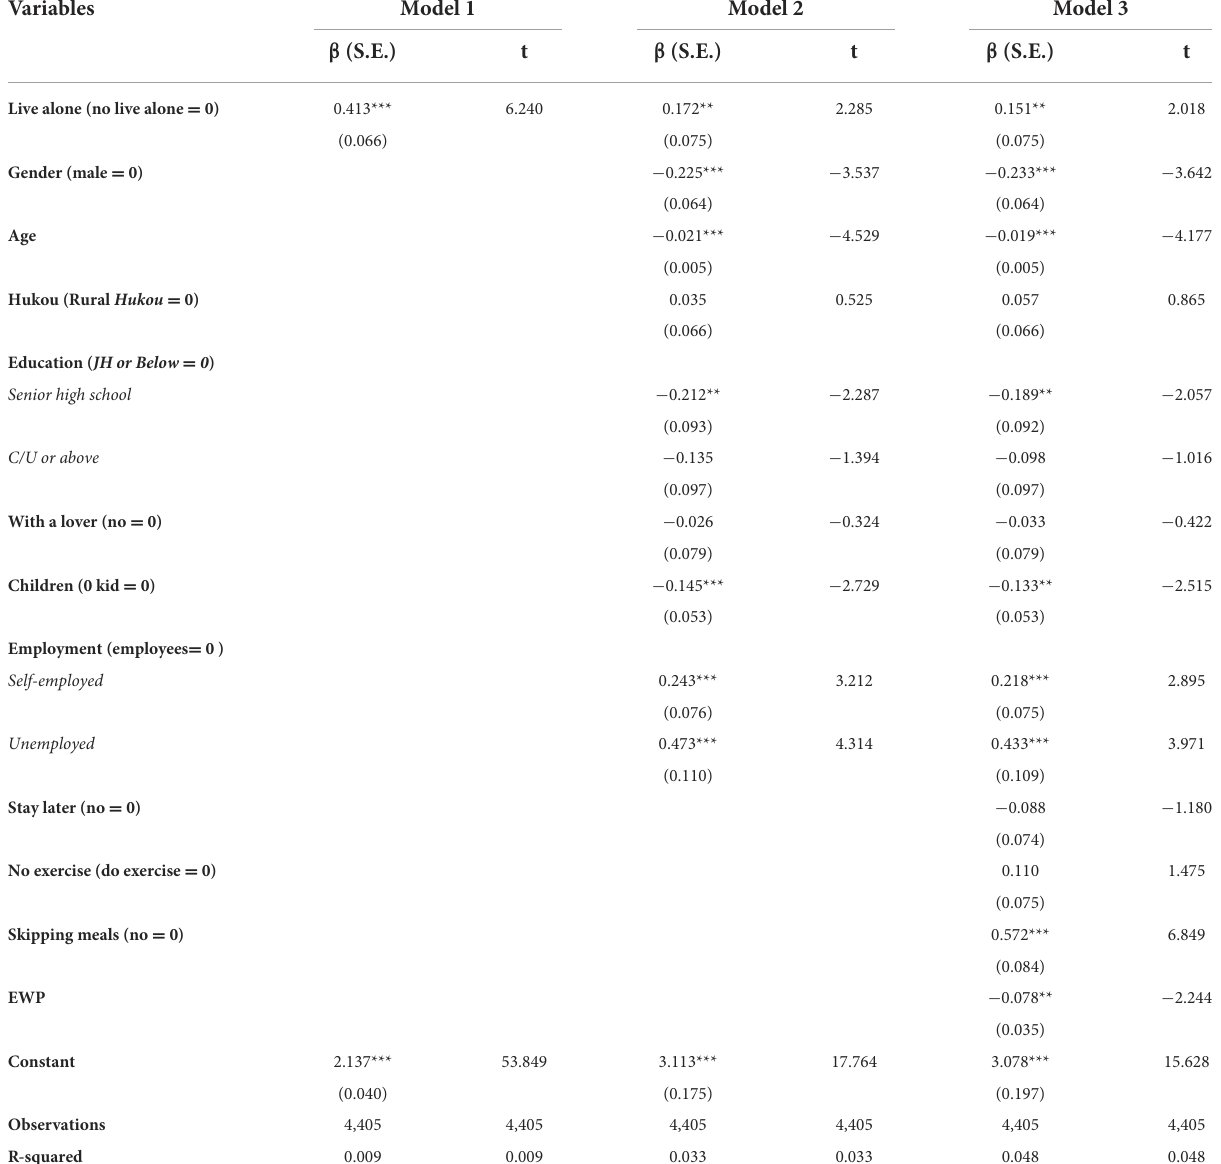
TABLE 2 Regression results of effect of the live alone on mental health.